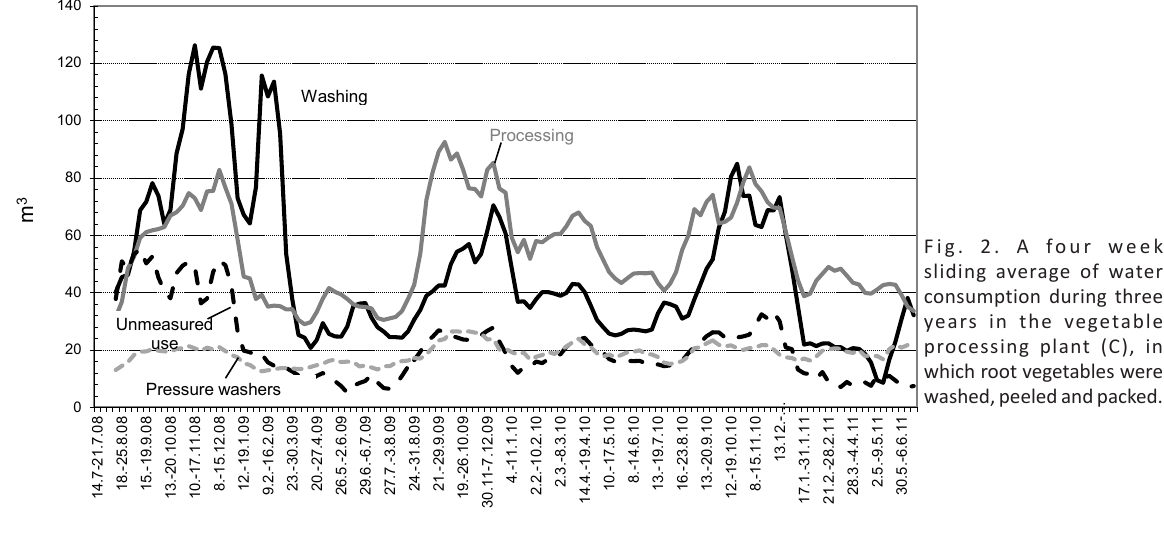
Fig. 2. A four week sliding average of water consumption during three years in the vegetable processing plant (C), in which root vegetables were washed, peeled and packed.